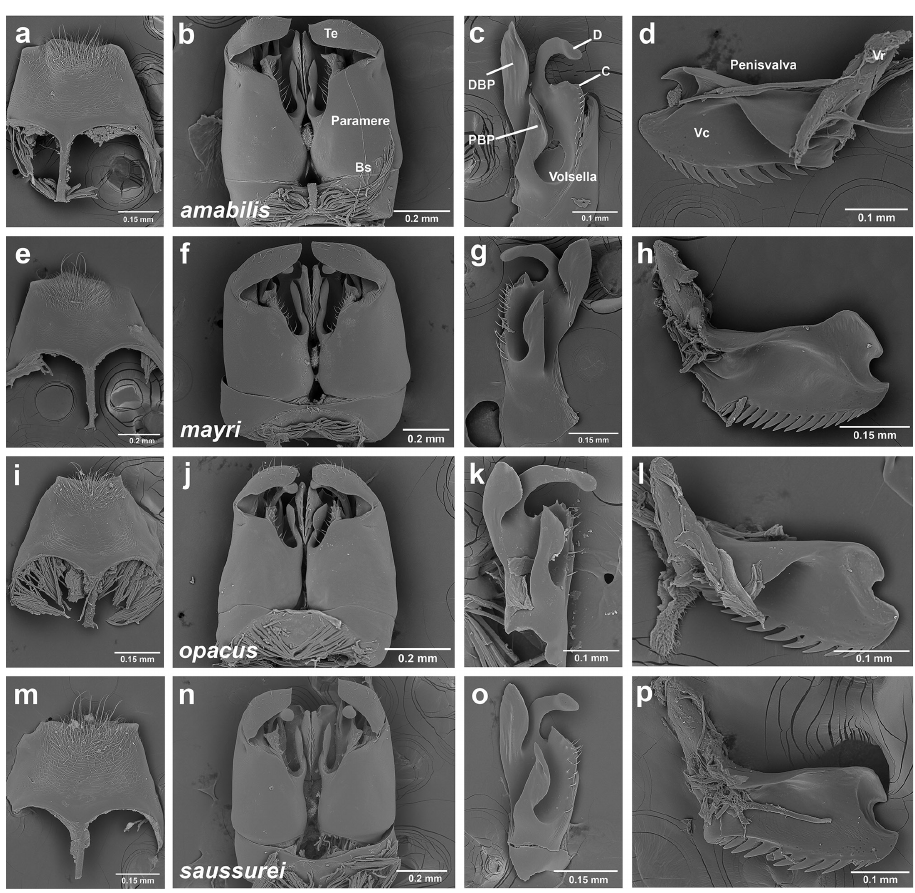
Figure 9. Sericomyrmex male genitalia. S. amabilis ( a – d ) S. mayri ( e – h ) S. opacus ( i – l ) S. saussurei ( m–p ). Abdominal sternum IX, ectal view ( a, e, i, m ) genital capsule, ventral view ( b, f, j, n ) volsella, mesal view ( c, g, k ,o ) and penisvalve, mesal view ( d, h, l, p ). Bs Basimere Te telomere D digitus C cuspis DBP distal basivolsellar process PBP proximal basivolsellar process Vr valvura Vc